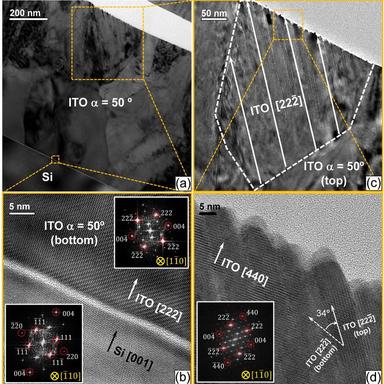
Evolution of the crystallographic orientation of an ITO OAD film deposited by Xe IBS at α = 50◦. (a) Cross-section bright-field TEM overall observation of the ITO OAD film. (b) High-resolution TEM micrograph of the Si/ITO OAD interface with the corresponding FFT of each layer. (c) Bright-field TEM detail of the top part of the film. (d) High-resolution TEM micrograph of the top part of the film together with the associated FFT diffractogram of the region.